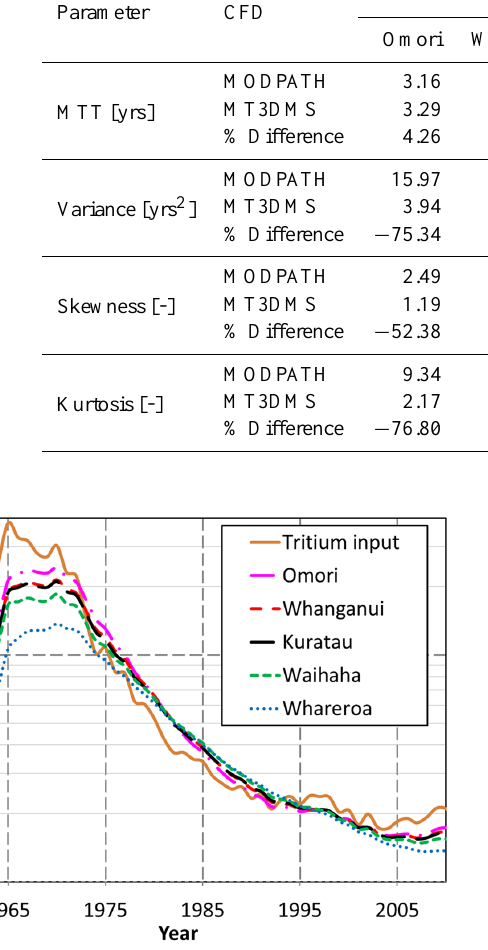
Figure 3. Annual tritium input and the baseflow tritium concentra- tions calculated by MODPATH for five watersheds from 1955 to 2010. Watersheds are listed in order of increasing